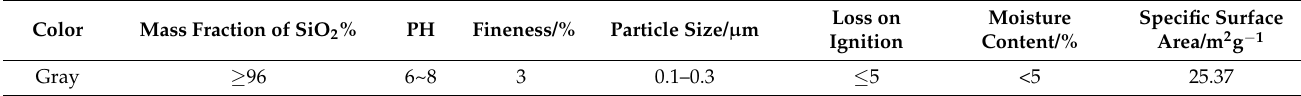
Table 2. Silica fume